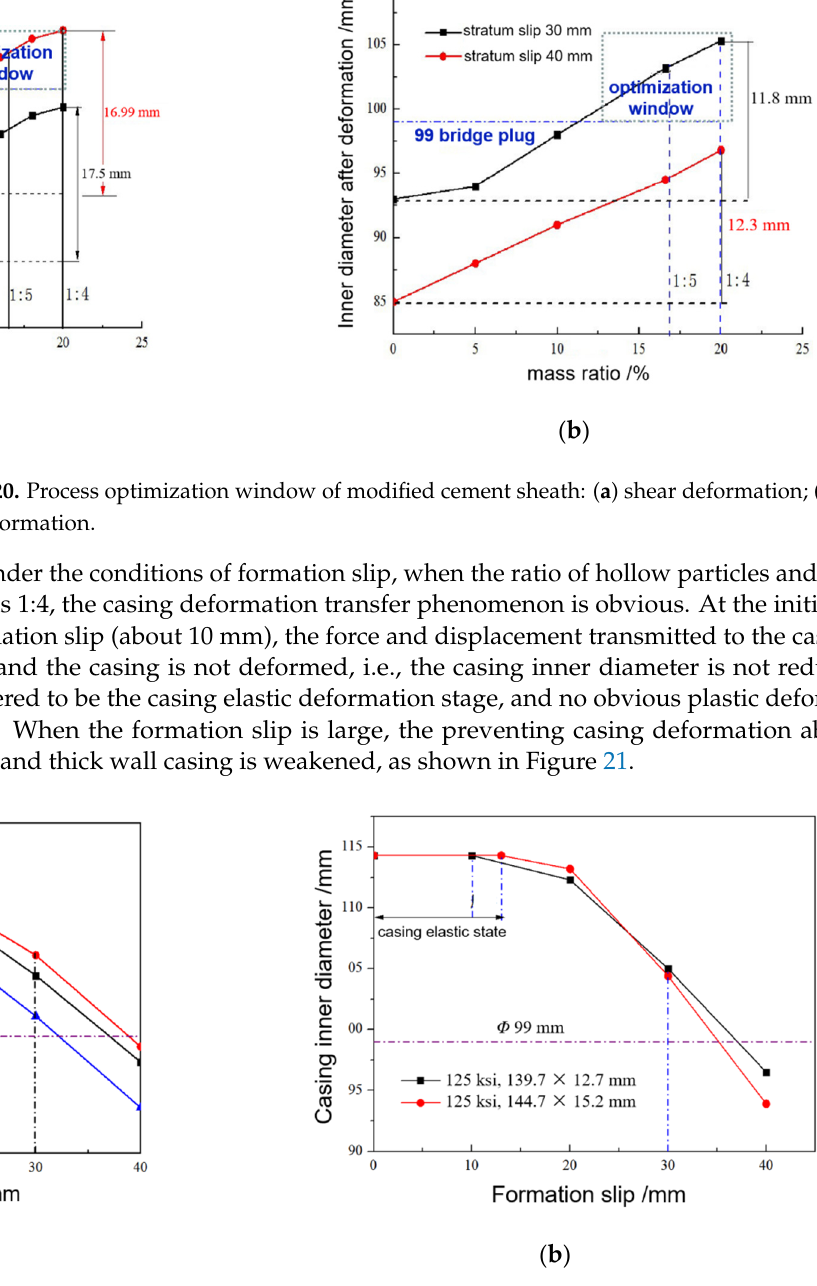
Figure 21. Influence of steel grades and wall thickness on deformation absorption: ( a ) steel grades; ( b ) wall thickness.